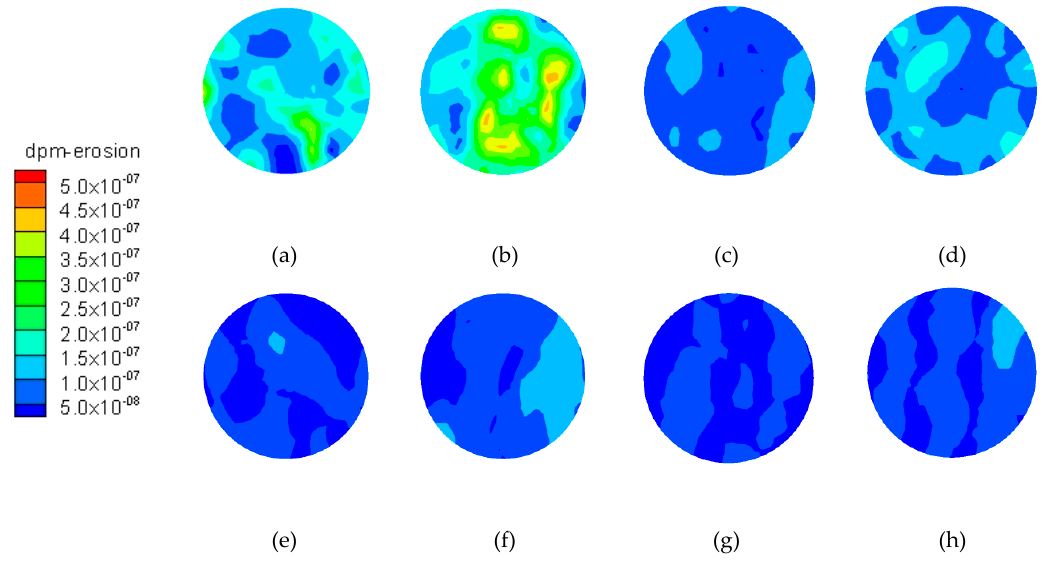
Figure 12. Wear contours of test samples under different particle diameters: ( a ) condition set 1, 225 mm; ( b ) condition set 1, 316 mm; ( c ) condition set 2, 225 mm; ( d ) condition set 2, 316 mm; ( e ) condition set 3, 225 mm; ( f ) condition set 3, 316 mm; ( g ) condition set 4, 225 mm; ( h ) condition set 4, 316 mm.